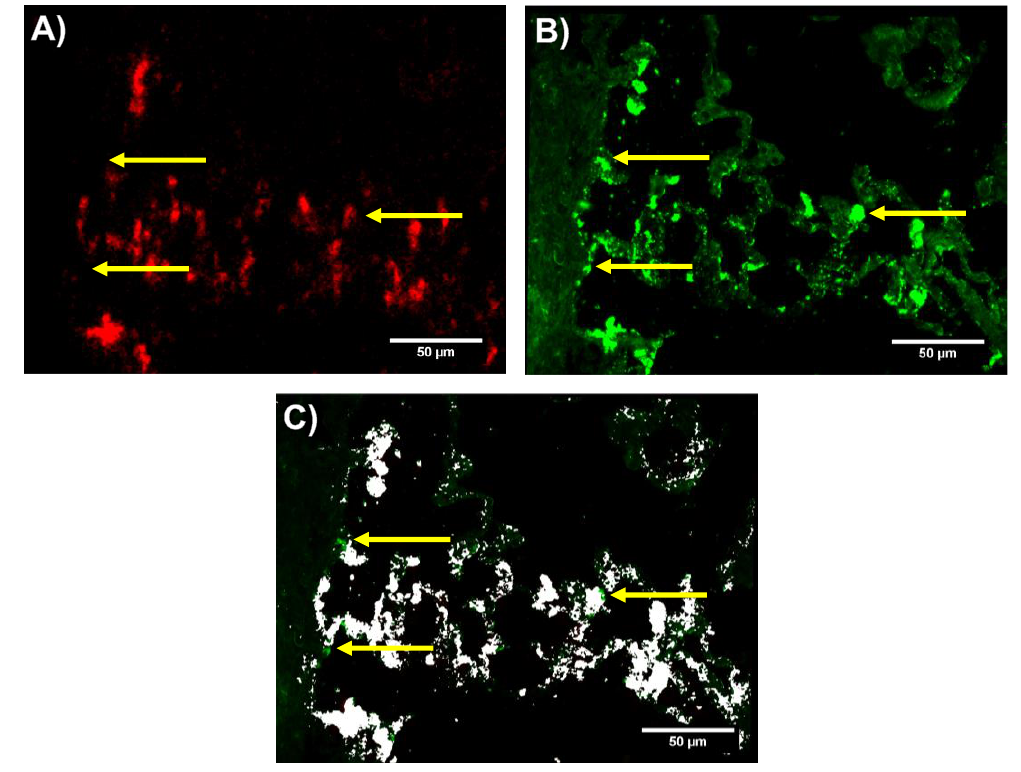
Figure 5. Comparison of ToF-SIMS 54 Fe + signal distribution and dark-field microscopy (DFM) images. Image taken from Figure 3. ( A ) 54 Fe + ToF-SIMS signal (red); ( B ) DFM signal (green) taken before washing and ToF-SIMS analysis; and ( C ) Colocalization of ( A , B ). A high degree of correlation is evident (white overlay). The Pearson correlation coefficient for this image was 0.541. Arrows point to green spots ( B ) which were detected by DFM, but not by ToF-SIMS.